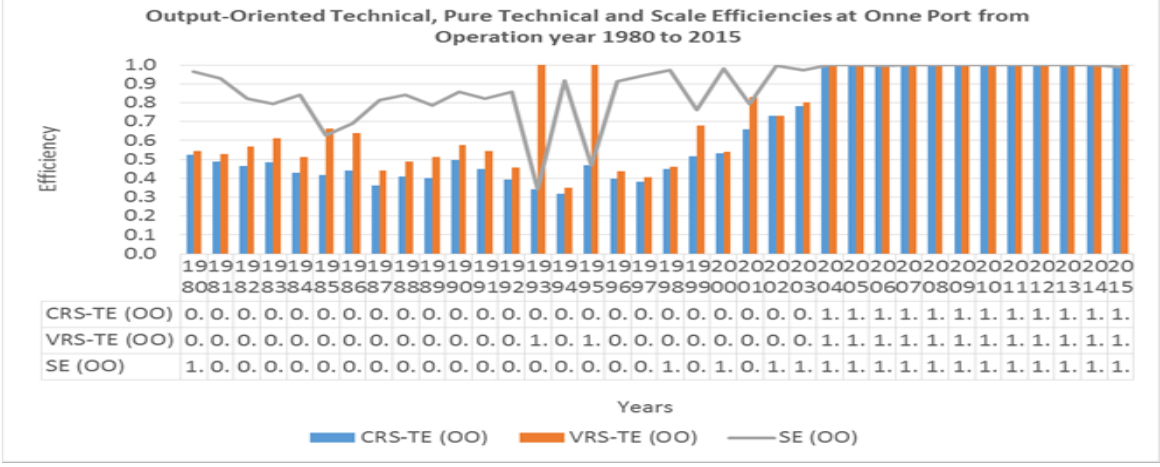
Figure 10: CRS – Technical Efficiency (Output-oriented) and CRS – Scale Efficiency (Output- oriented) at Onne Port Complex from 1980 –